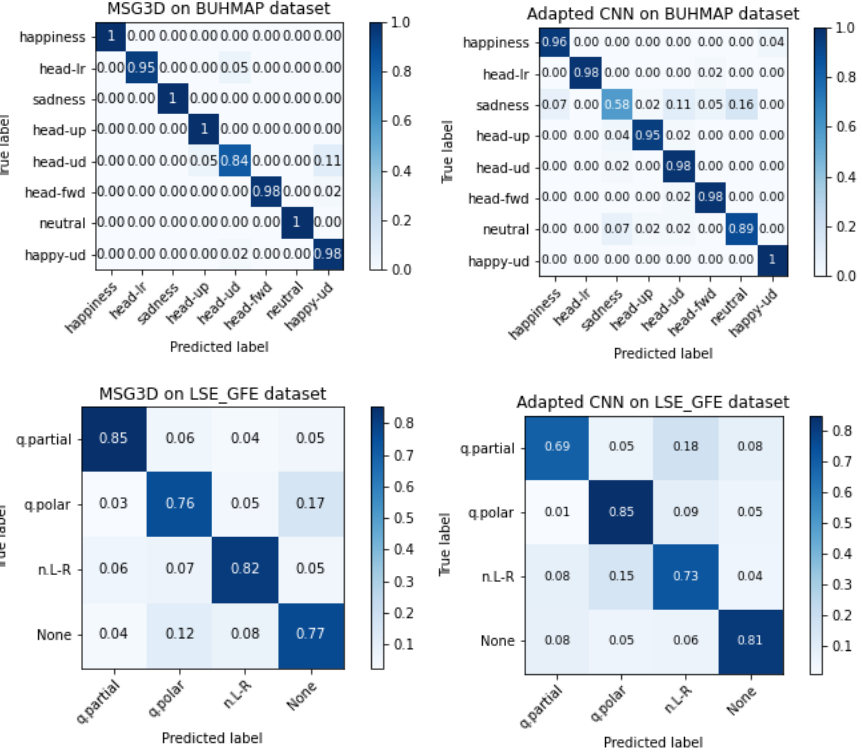
Figure 10. Confusion matrices of MSG3D ( left ) and custom CNN models ( right ) for BUHMAP ( top ) and LSE_GFE ( bottom